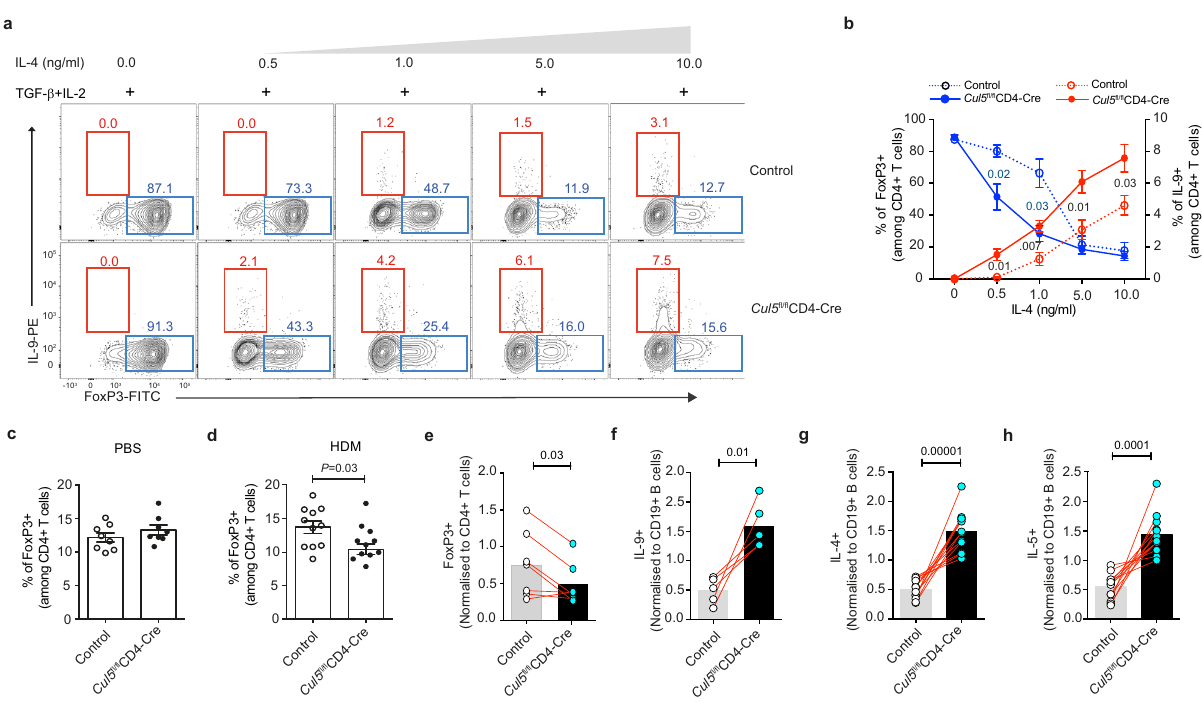
Fig. 7 Cul5 regulates fate choice in CD4 + T cells. a Representative fl ow plots showing the frequencies of FoxP3 + and IL-9 + cells. Naive CD4 + T cells from control and Cul5 fl / fl CD4-Cre mice were cultured in iTreg polarizing (TGF- β + IL2 + anti-IFN γ ) condition with increasing concentrations of IL-4. Cells were stained for FoxP3 and IL-9 on day 5. b Compiled data of ( a ) showing the frequencies of FoxP3 + (blue) and IL-9 + (red) cells. For FoxP3 + cells, n = 3 control, n = 4 Cul5 fl / fl CD4-Cre , for IL9 + cells n = 4 control, n = 5 Cul5 fl / fl CD4-Cre biologic replicates of cells examined in three independent experiments. c Compiled data showing the frequencies of FoxP3 + cells in 8 – 10-week-old control and Cul5 fl / fl CD4-Cre mice treated with PBS. n = 8 control and Cul5 fl / fl CD4-Cre mice examined in two independent experiments. ( d ) HDM treated mice n = 11 control and Cul5 fl / fl CD4-Cre mice examined in three independent experiments. Mixed bone marrow chimeras. 6 – 8-weeks-old Rag1-/- de fi cient recipients were sublethally irradiated and then injected with a 1:1 mixture of control (CD45.1 + ) and Cul5 fl / fl CD4-Cre (CD45.2 + ) donor bone marrow cells and allowed to reconstitute for 8 weeks. These mice were then treated with a 2-week regimen of house dust mite (HDM), and their lung cells were analyzed by fl ow cytometry. e Proportion of FoxP3 + cells that came from each donor. The percent of control (CD45.1 + ) and Cul5 fl / fl CD4-Cre (CD45.2 + ) FoxP3 + cells was normalized to the percent of CD4 + T cells from the same donor. n = 7 recipient mice were examined in two independent experiments. Two donors of each genotype were used to reconstitute these recipients. Each recipient received cells from one mouse of each genotype. Proportion of cytokine producing cells. To calculate the contribution from each donor CD45.1 “ cytokine + ” cells or CD45.2 “ cytokine + ” cells were normalized to CD19 + cells. f Proportion of IL-9 + cells from CD45.1 (WT) and CD45.2 (Cul5 de fi cient), n = 5 recipients were examined in one experiment. g - h Proportion of IL-4 + and IL-5 + cells, n = 12 recipients were examined in two independent experiments. Data is presented as mean±SEM in panels b – d . In panels e - h data is represented as mean. p- value was calculated by unpaired two tailed t- test used in panels b - d and paired two-tailed t- test in panels e - h . Source data are provided as a Source Data fi